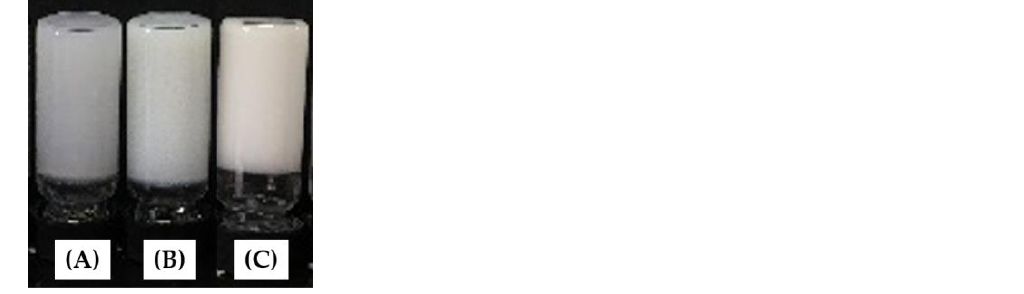
Figure 2. Photographs of vials showing gelation of gelators in water: ( A ) 2C12-Lys-Na, ( B ) 2C12-Lys-K, and ( C ) 2C14-Lys-K.